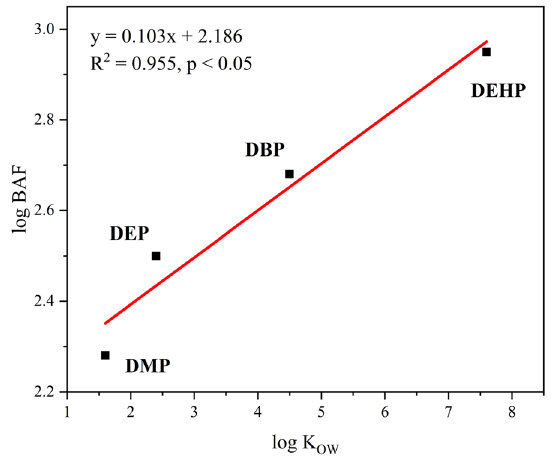
Fig. 3 The relationship between the mean logarithmic bioaccumulation factors (log BAFs) and the octanol–water partition coefficients (log K OW ) of the phthalate